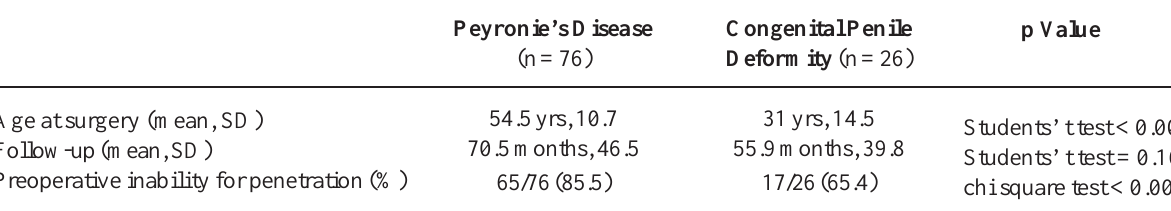
Table 1 – Patient characteristics.